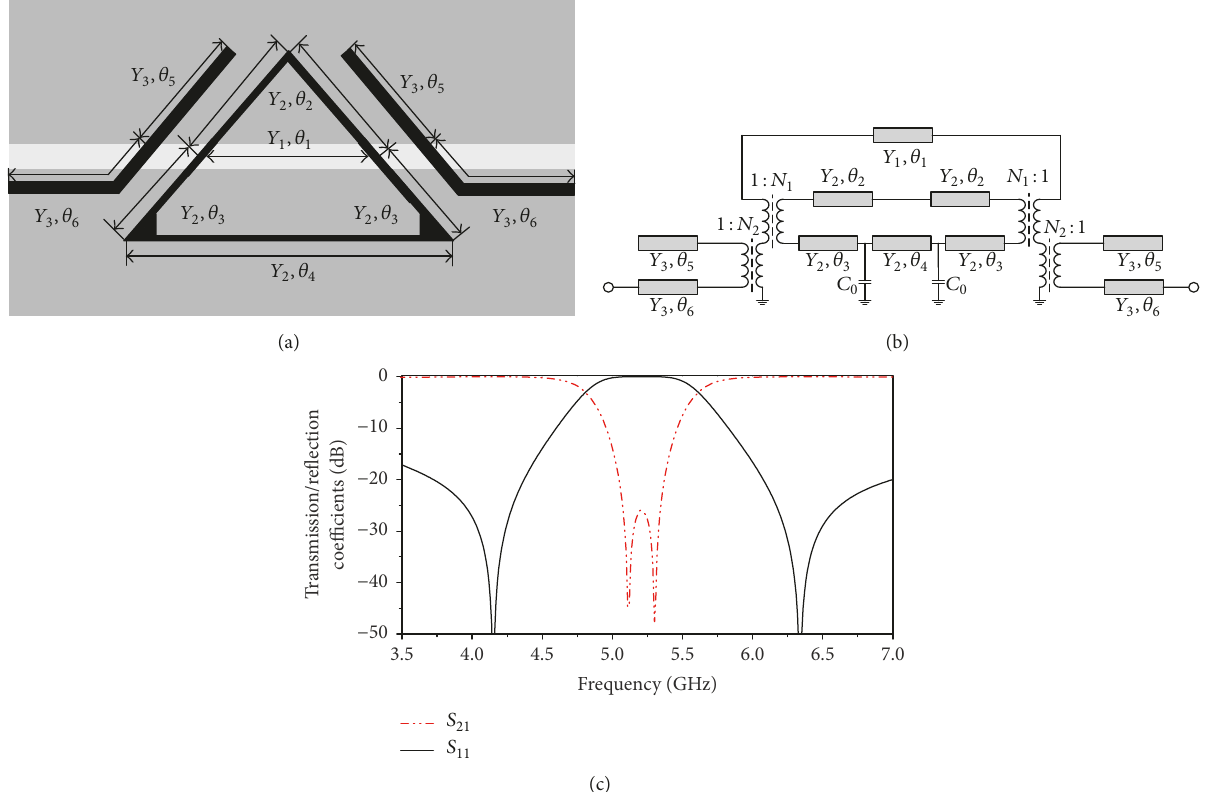
Figure 5: A microstrip triangular loop resonator loaded with backside slotline portion. (a) Diagram, (b) equivalent circuit model, and (c) simulated